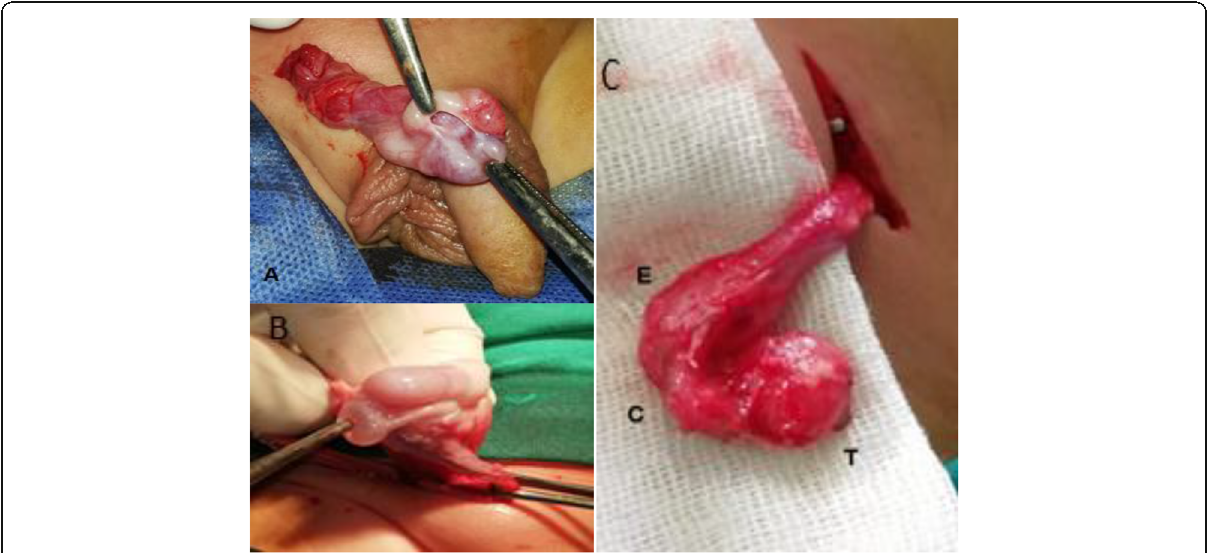
Fig. 4 a Epididymal caput cyst with epididymal body detached from the testis. b Congenital epididymal caput cyst (non-toothed forceps). c